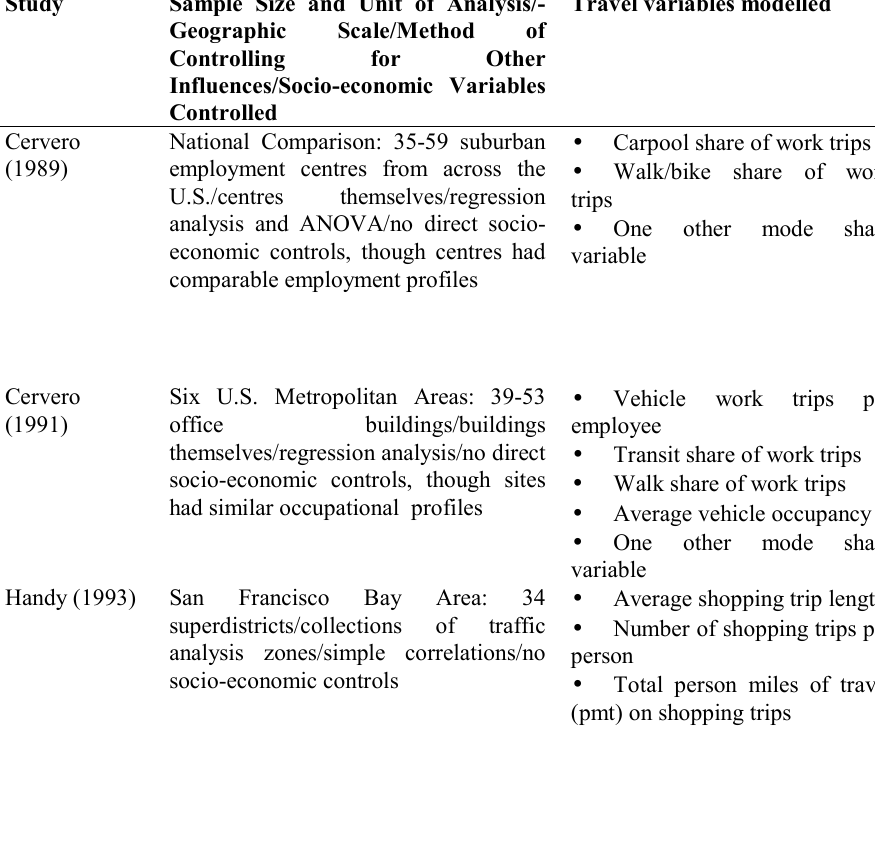
Table 3. Studies Testing Neighbourhood and Activity Centre Design Variables